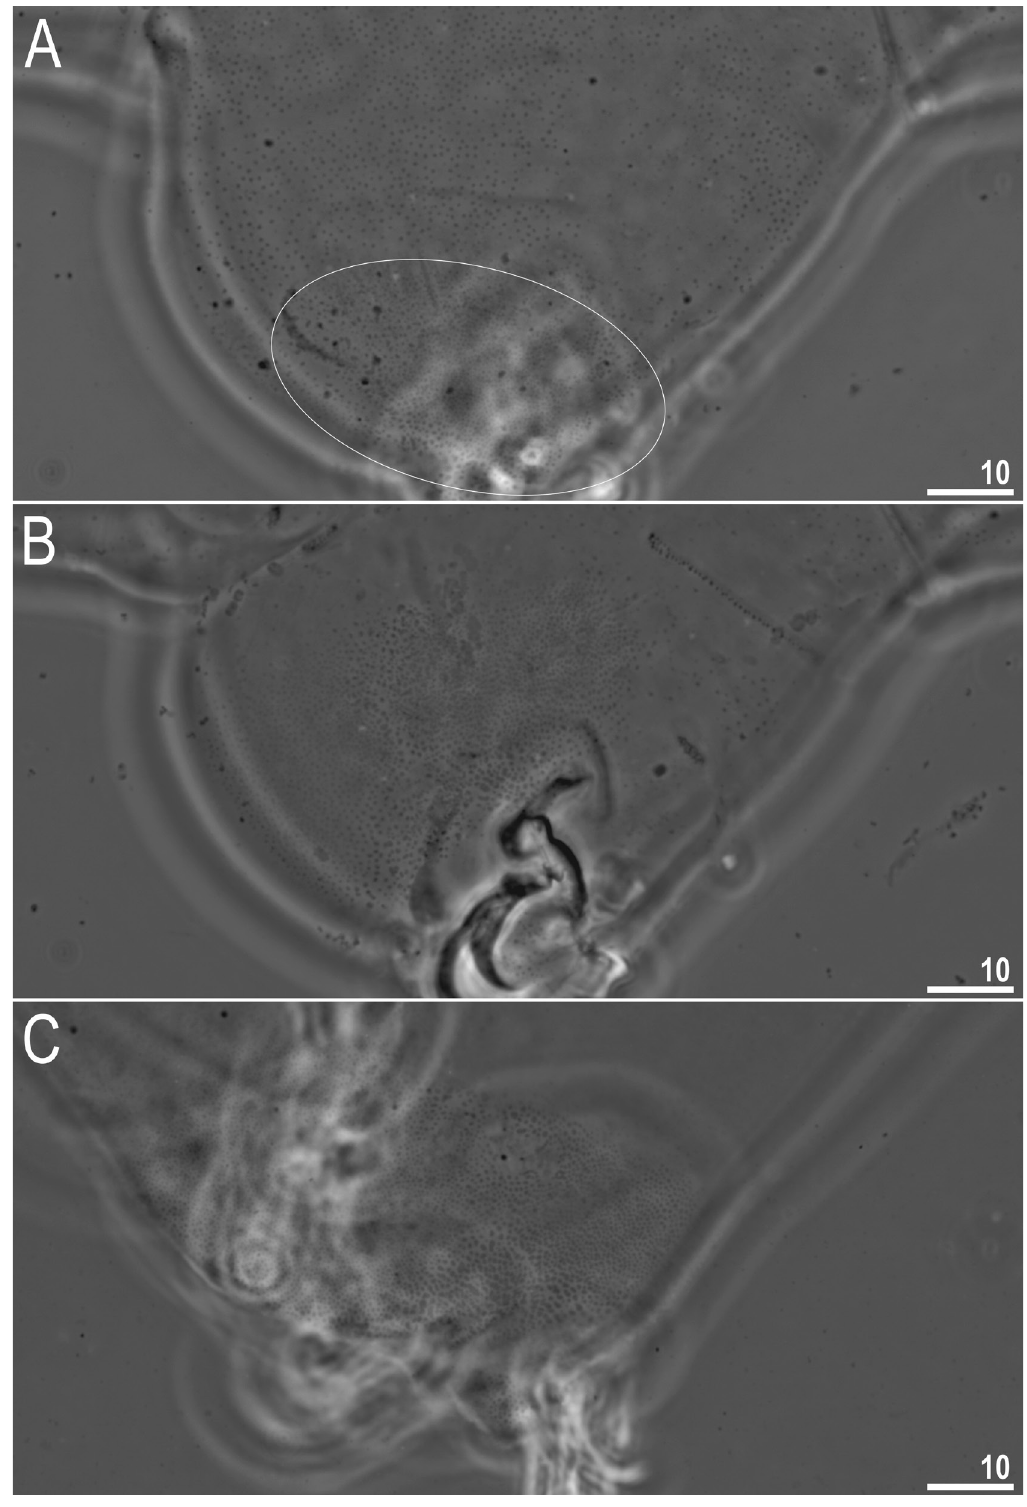
Fig. 12. Tenuibiotus zandrae sp. nov. Patches of dense granulation on legs seen in PCM (paratypes). A . External granulation on leg III (patch of dense granulation encircled). B . Internal granulation on leg III. C . Granulation on leg IV. Scale bars in